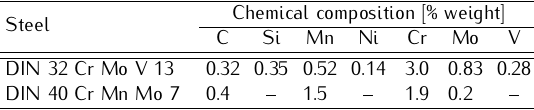
Figure 2. Optical micrograph of cross-section (left) and SEM micrograph of the white layer surface (right), of DIN 32 Cr Mo V 13 plasma nitrided steel. Table 1. Chemical composition of the nitrided steels.